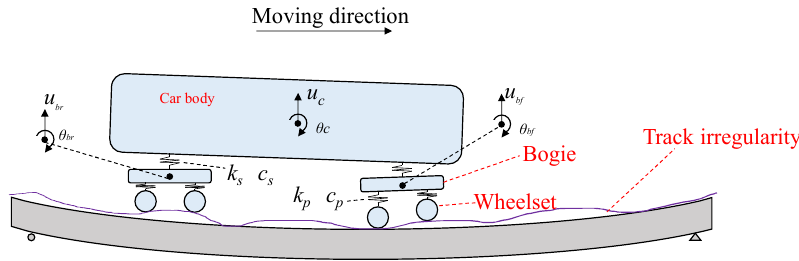
Figure 1. Vehicle–bridge coupled system.